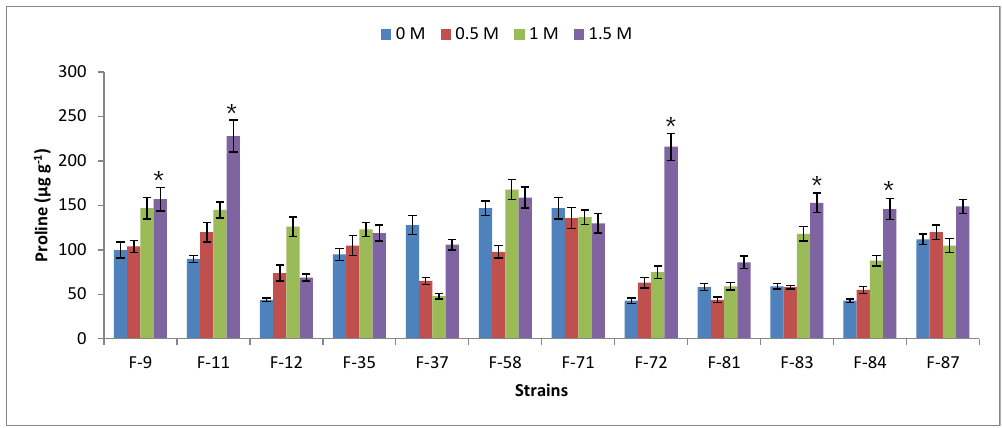
Figure 3. Effect of NaCl concentrations on proline content of halotolerant bacteria. Bars represent mean ± SE of three replicates. Treatments followed by * indicate significant difference over control using Duncan’s multiple range test ( p ≤ 0.05).